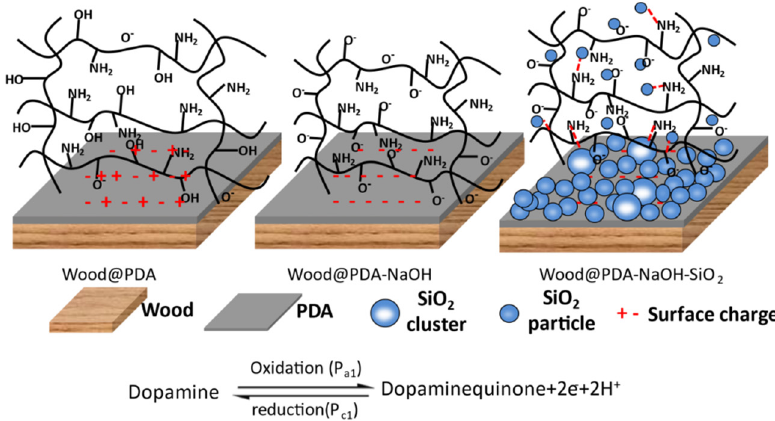
Figure 2. Model diagram of polydopamine (PDA) deprotonation process.